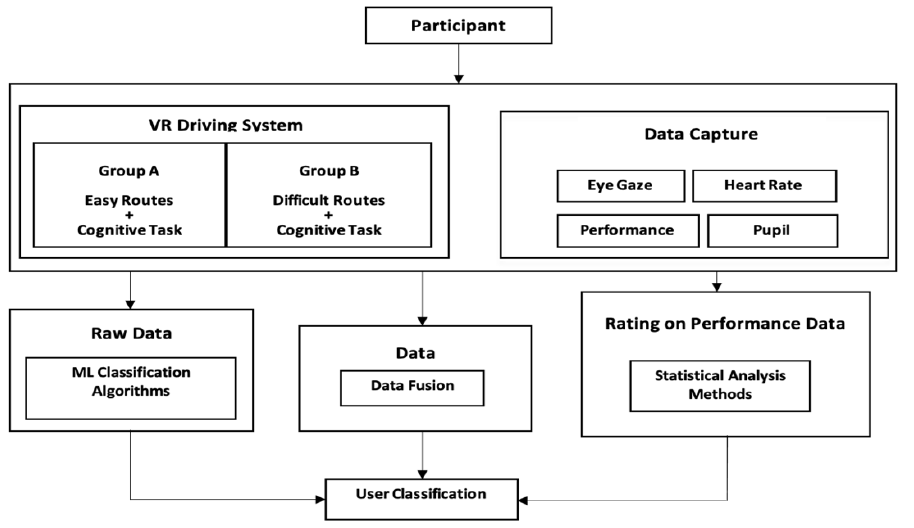
Figure 1. The structure of the VR driving system.